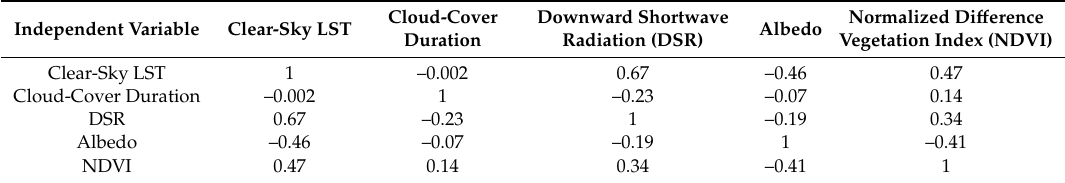
Table 2. Pearson correlation coe ffi cients between 5 independent